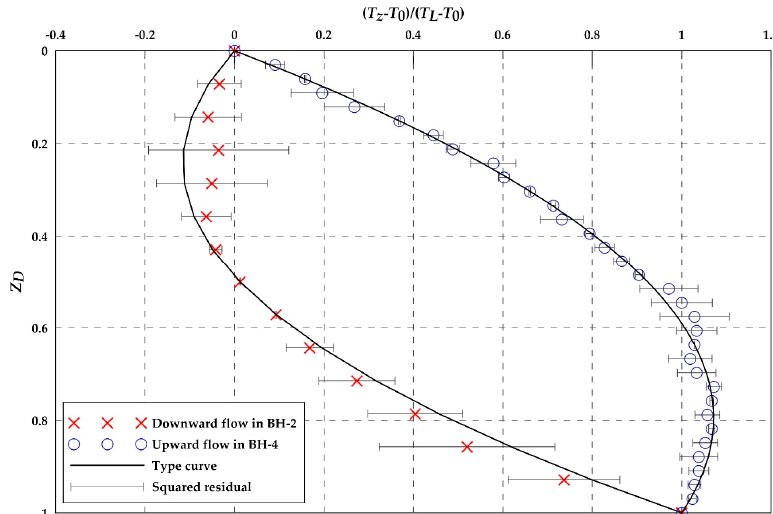
Figure 9. Comparison of normalized vertical distance ( z D ) versus normalized temperature ( Tz–T 0 )/( T L –T 0 ) between the theoretical predictions and measured data from BH-2 and BH-4. A negative β value indicates upward groundwater flow with a warm origin, whereas a positive β value indicates downward groundwater flow with a cool origin.